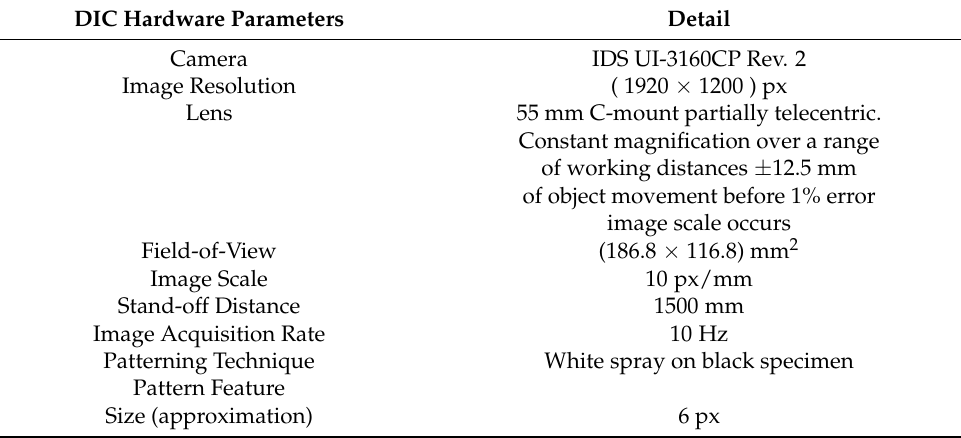
Table 3. DIC Hardware